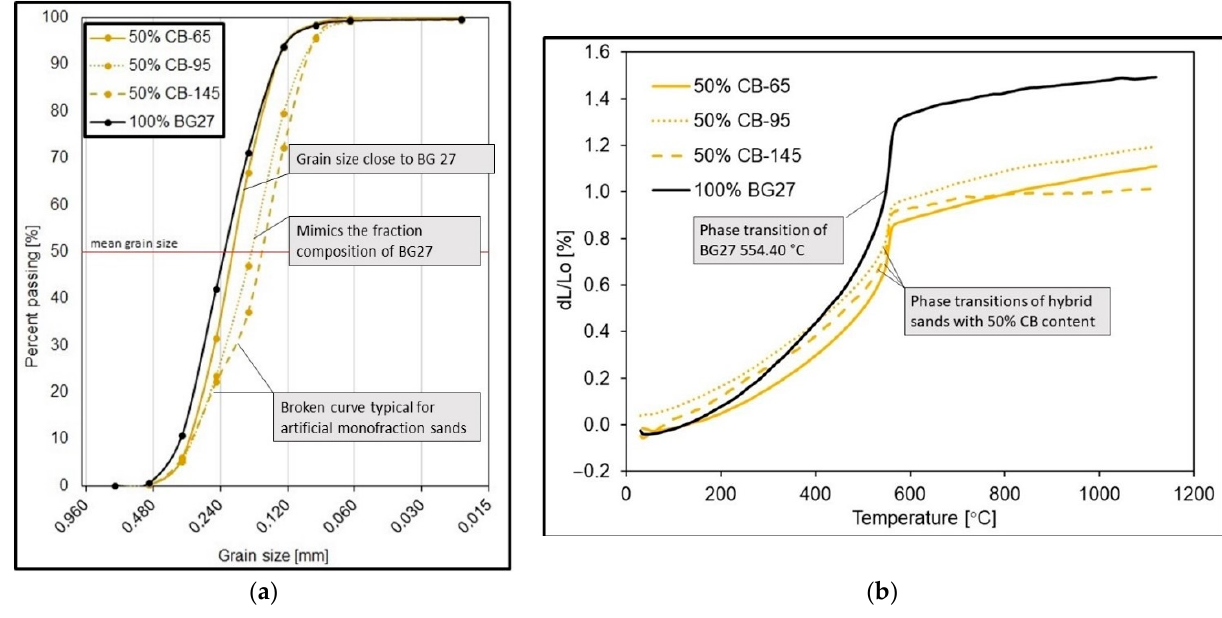
Figure 7. ( a ) Cumulative curves of granularity and ( b ) dilatation curves for 100% BG27 and hybrid sands with 50% CB content.